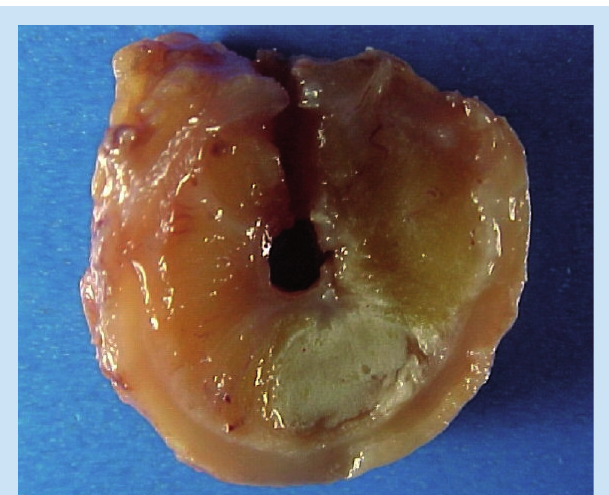
Fig. 2. Cross-section of the colon demonstrating massive submucosal adipose deposition and minute calibre of the